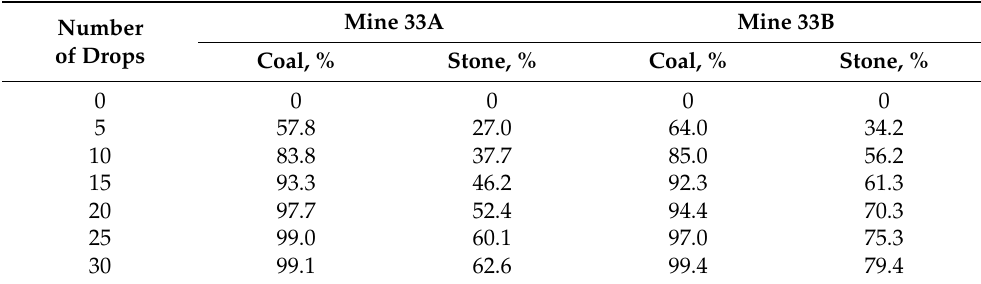
Table 1. Output of 80-0 mm class depending on number of drops—comparative results for coal type 33 [43].